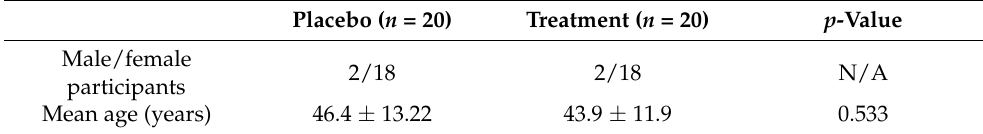
Table 1. Baseline characteristics (mean value ± SD).